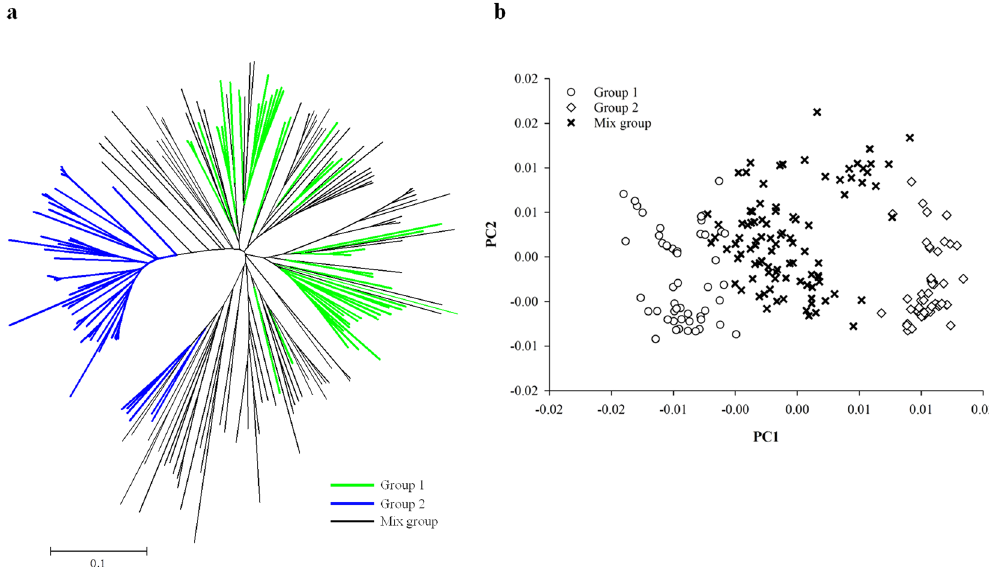
Figure 2. Neighbor-joining tree and PCA plot for 217 rice maintainer lines based on Cavalli-Sforza’ Chord genetic distance. ( a ) Neighbor-joining tree. ( b ) PCA plots of the first two components.